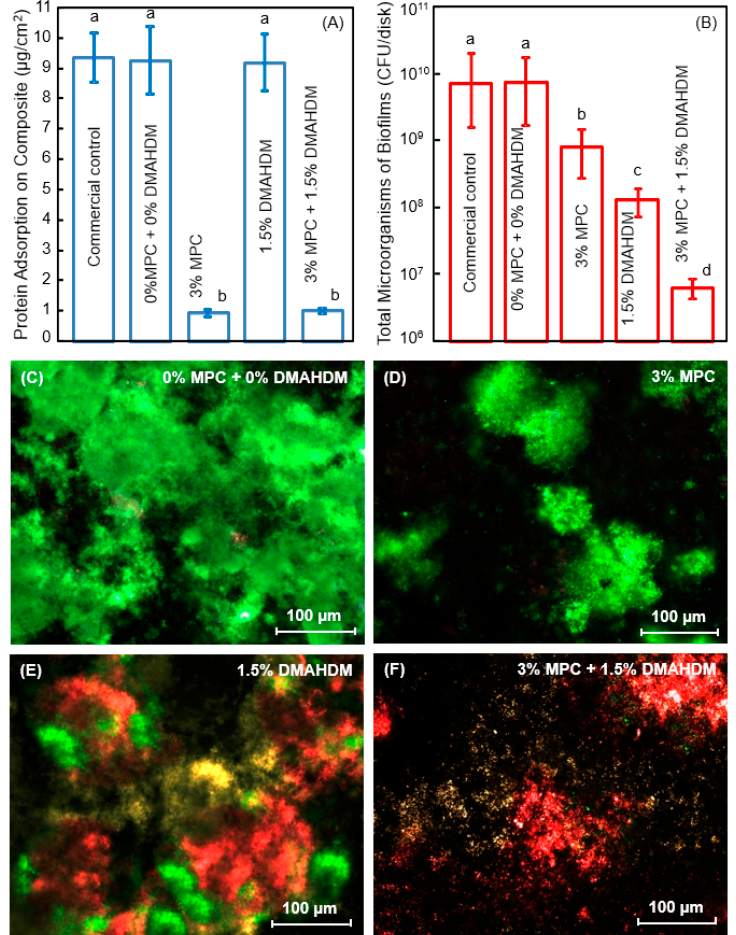
Figure 2. Protein-repellent and antibacterial polymeric composite. ( A ) Protein adsorption onto composites; ( B ) Dental plaque microcosm biofilm cfu of total microorganisms on composites cultured for 2 days. Note the log scale in y axis; ( C – F ) Representative live/dead images of biofilms on control composite, and composites with 3% MPC, 1.5% DMAHDM, and 3% MPC + 1.5% DMAHDM. The live bacteria were stained green, and the dead bacteria were stained red. Live and dead bacteria in close proximity yielded yellow/orange colors. In each plot, dissimilar letters indicate values that are significantly different from each other ( p < 0.05). (Reproduced with permission from [43]. Elsevier, 2015)